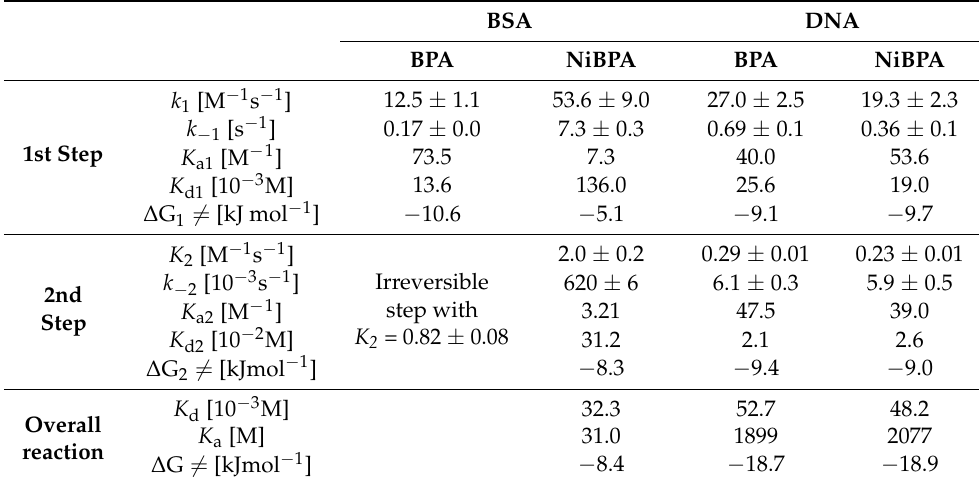
Table 2. Summary of rate constants and activation parameters for the interaction of BPA and NiBPA to BSA and ct-DNA at 25 ◦ C.